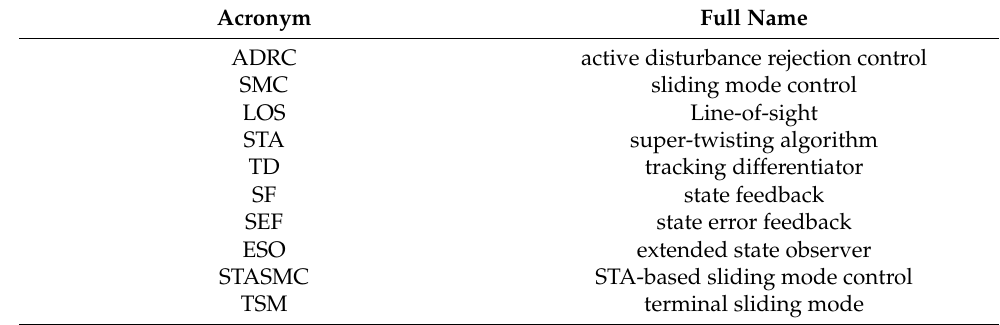
Table A1. The list of acronyms used in the